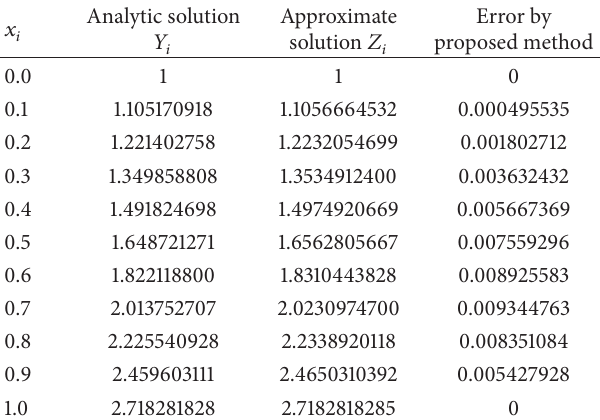
Table 2: Numerical results of Example 2: ℎ = 10 −1 .